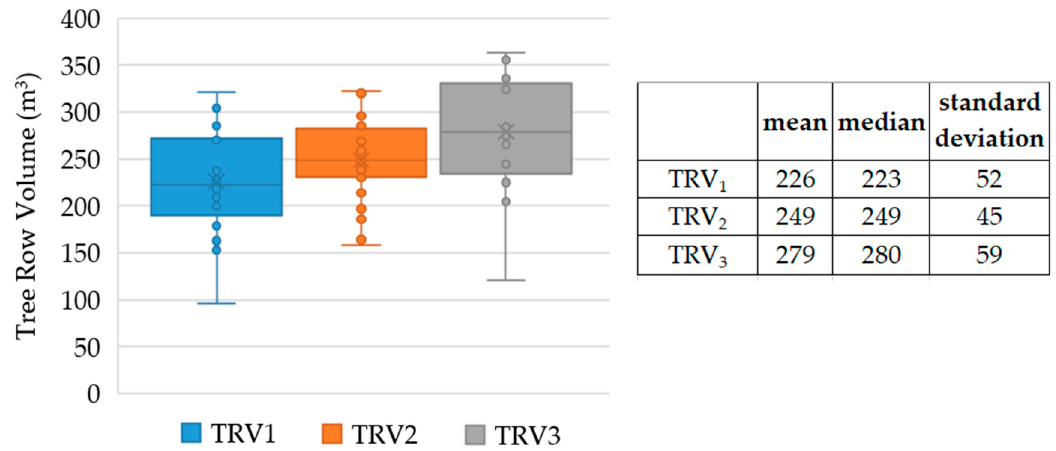
Figure 9. Statistical analysis of the three distributions of the TRVs.